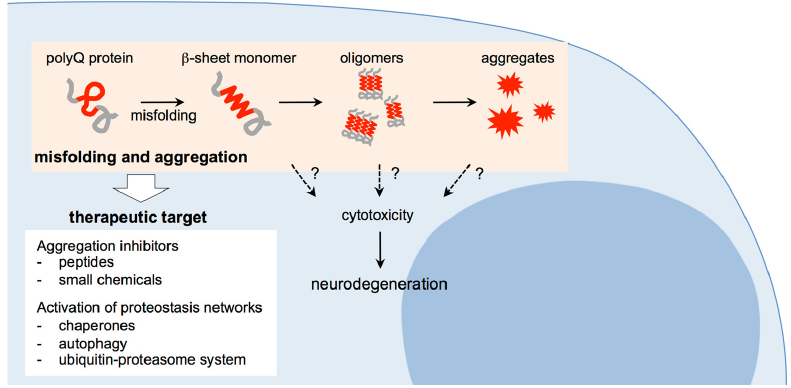
Figure 1. Proposed aggregation cascade of the expanded polyglutamine (polyQ) proteins and potential therapeutic targets for polyQ diseases.